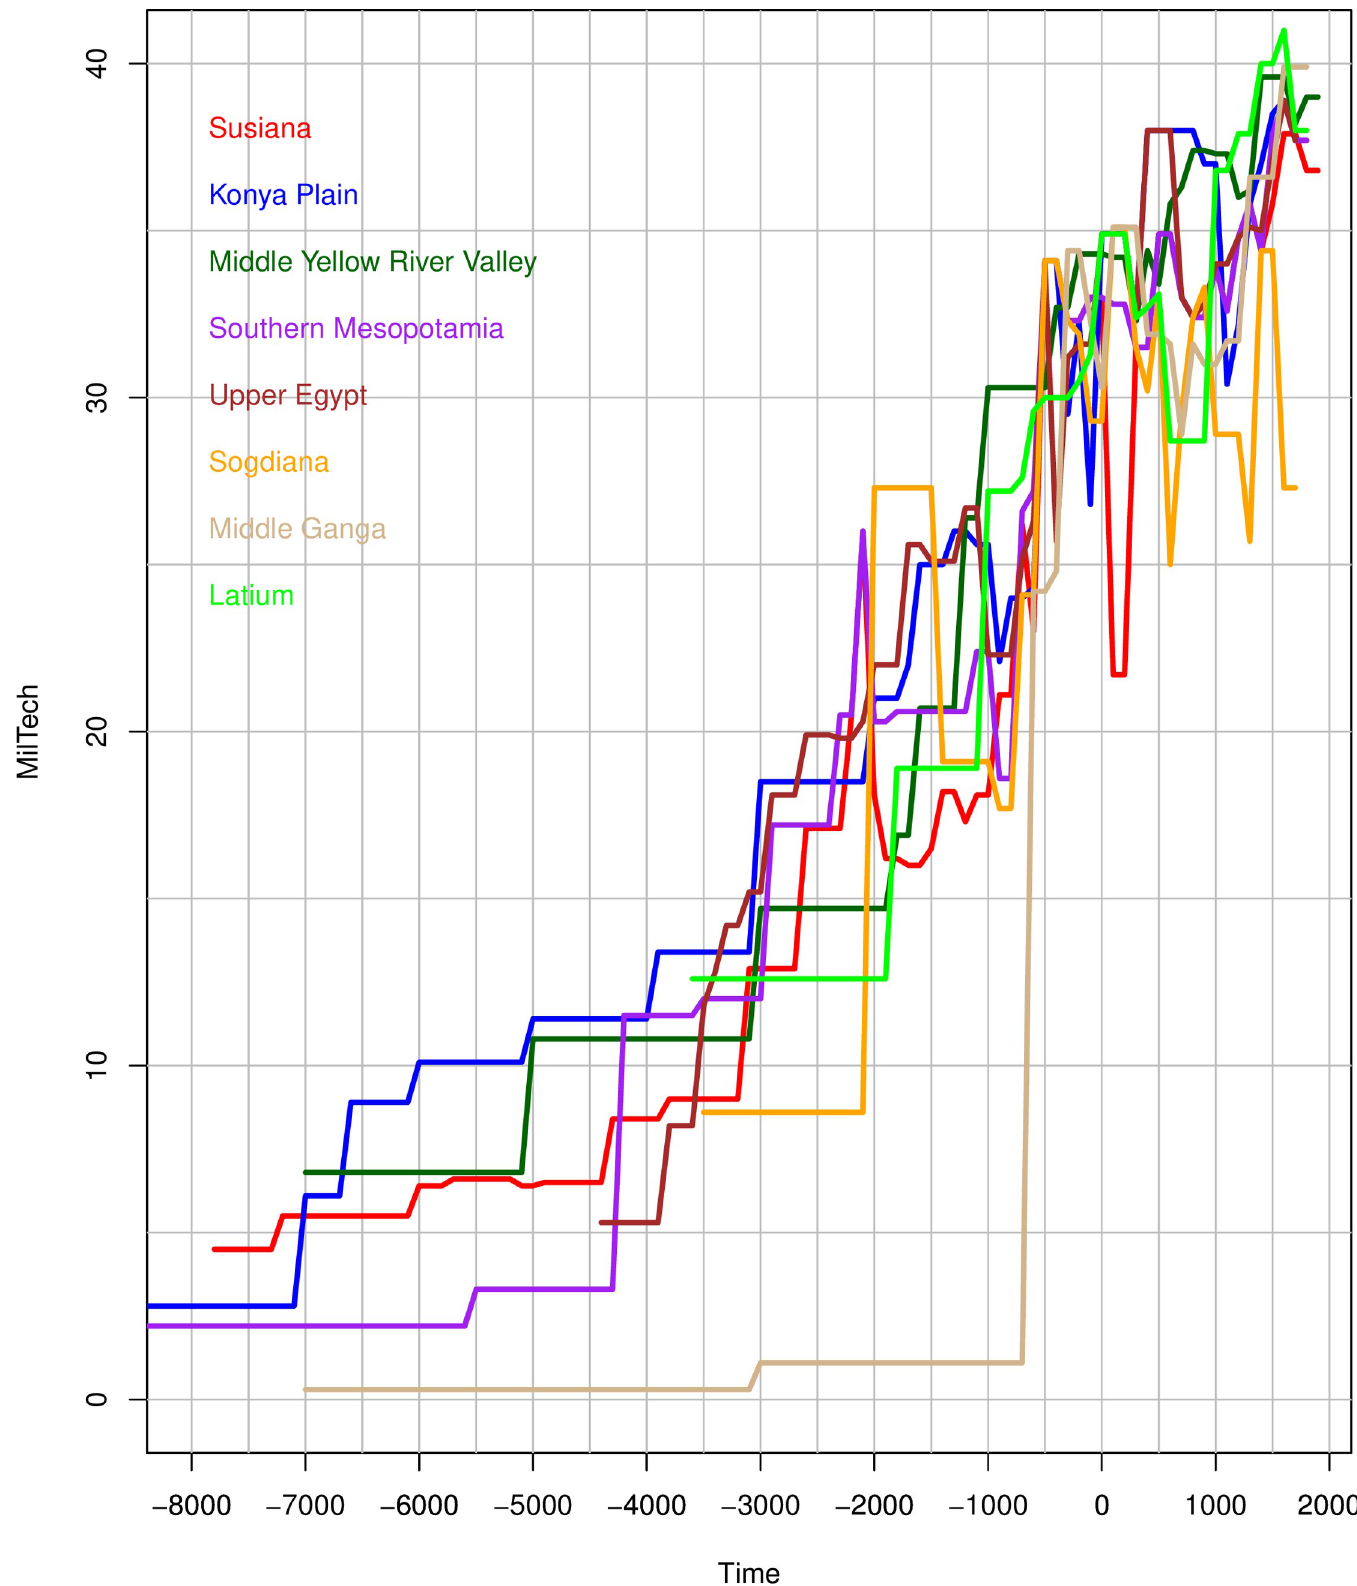
Fig 5. “Technological leaders”: NGAs that at some point achieved the highest MilTech score available at that time. https://doi.org/10.1371/journal.pone.0258161.g005 PLOS ONE | https://doi.org/10.1371/journal.pone.0258161 October 20,